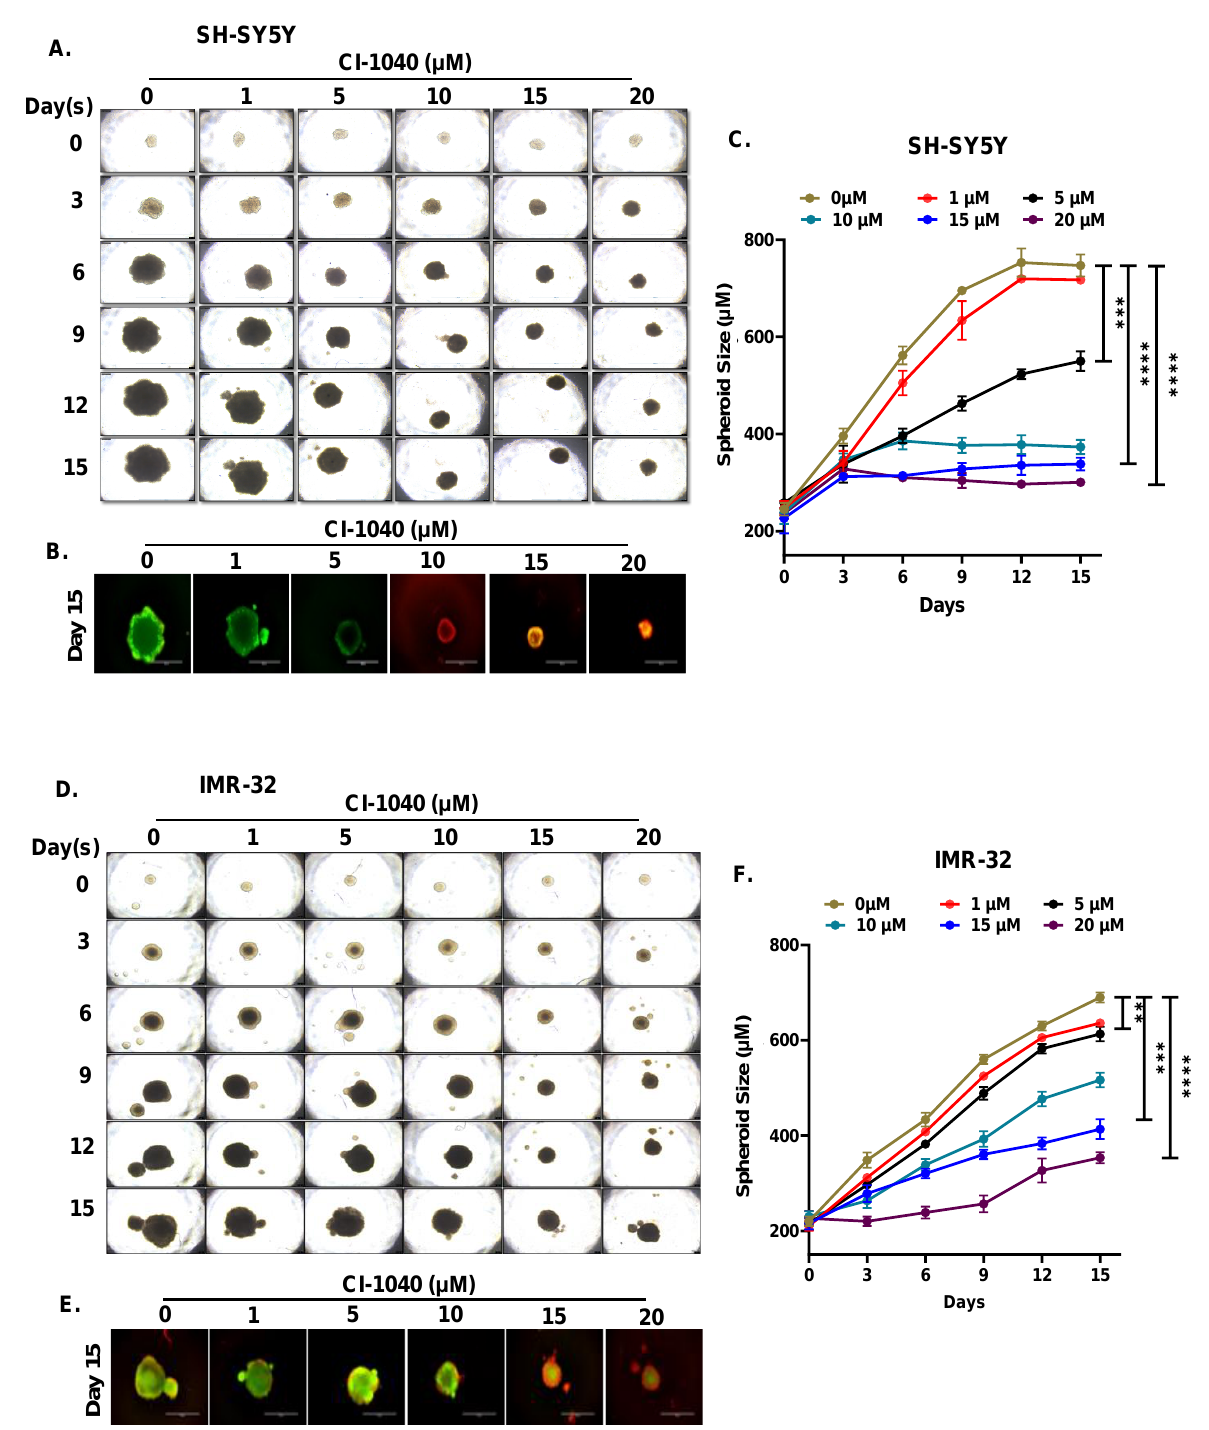
Figure 5. CI-1040 inhibits NB 3D spheroid tumor growth. NB 3D spheroids of MYCN amplified (IMR-32) and MYCN non-amplified (SH-SY5Y) cells were developed and treated with CI-1040 for 15 days. ( A – D ) Representative images of the 3D spheroid tumor growth at different days in response to CI-1040 treatment ( A ) SH-SY5Y ( D ) IMR-32. ( B , E ) Terminal day 3D spheroid tumor images stained with Calcein AM (Green; live cells) and EthD-III (Red; dead cells) fluorescence dyes. Size bar = 1 mm. ( B ) SH-SY5Y (E) IMR-32. ( C , F ) Quantitative 3D spheroid tumor growth showing reduction of tumor size in response to CI-1040 treatment ( C ) SH-SY5Y ( F ) IMR-32. ** p < 0.01, *** p < 0.001, and **** p <